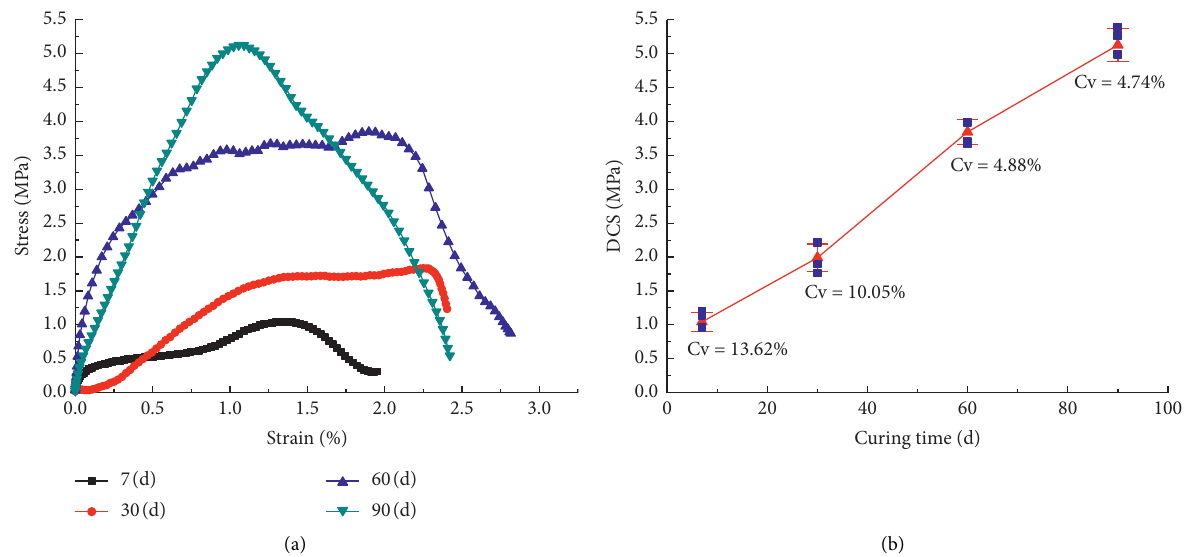
Figure 9: Test results of impact test. (a) The stress-strain curves of impact test. (b) Variation law of